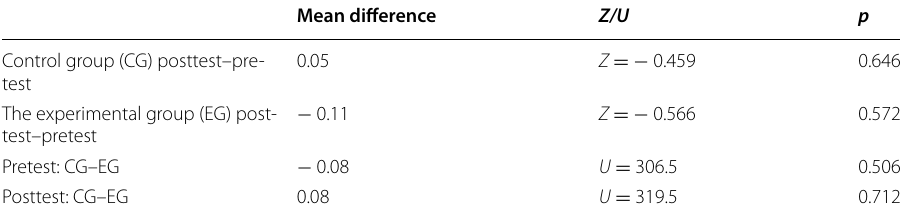
Table 7 Comparisons of the task response scores